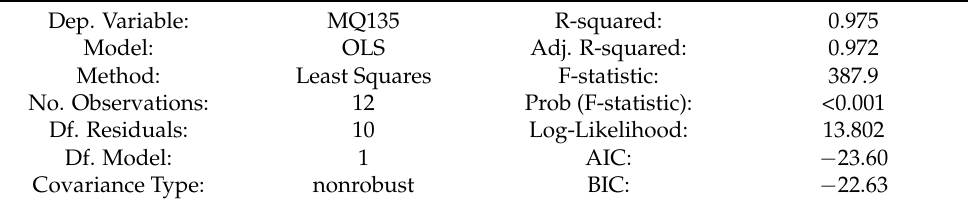
Table 5. OLS regression results (MQ135).